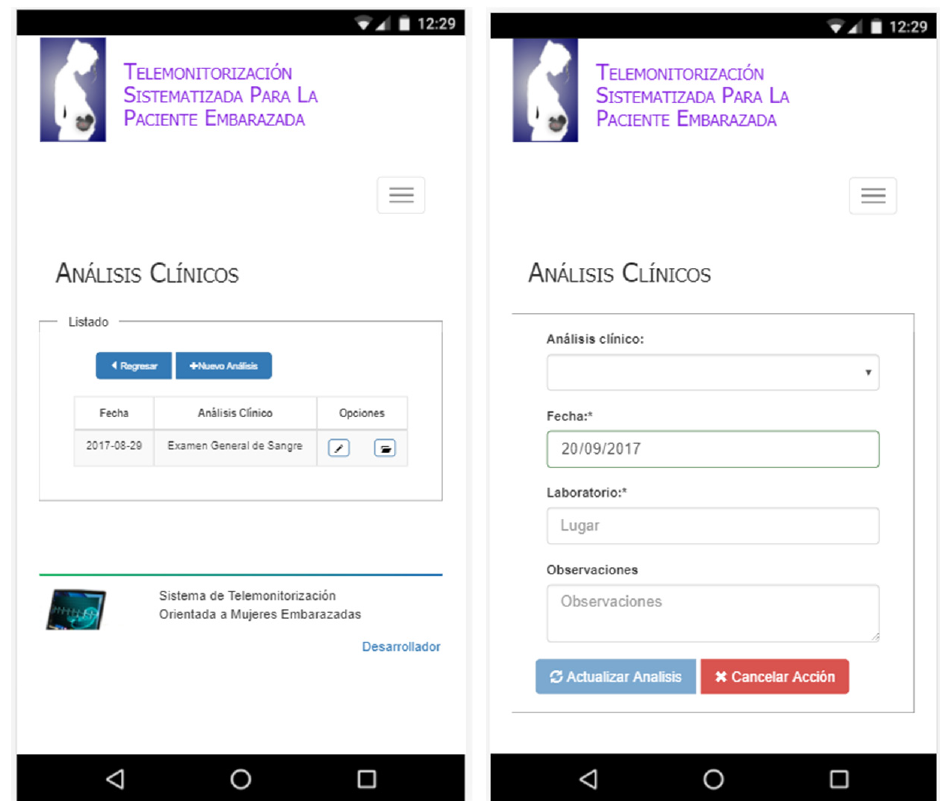
Figure 8. Clinical analyses (from left to right ): list and general record.